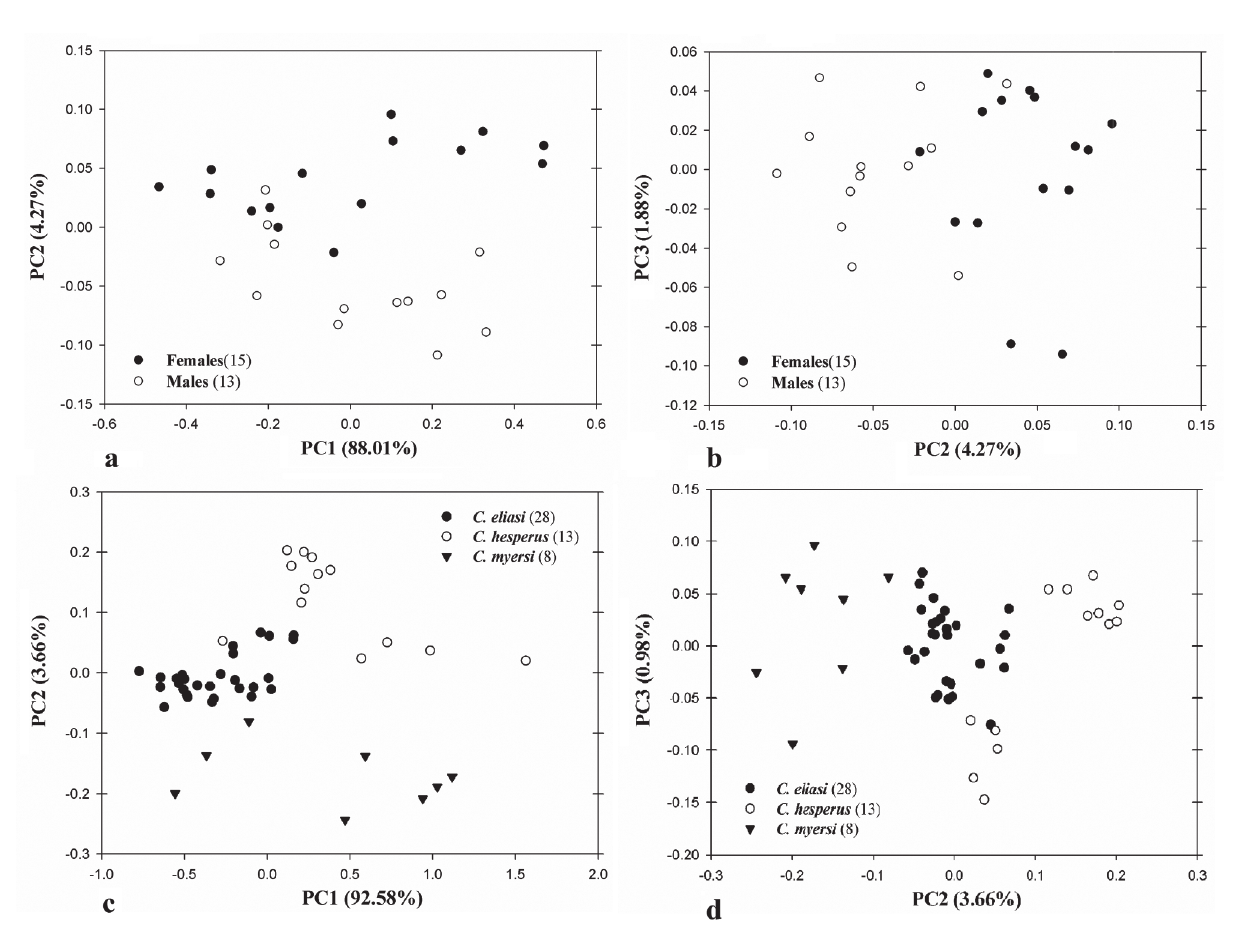
Fig. 6. Principal component analyses of morphometric data by sex of Chrysobrycon eliasi ( a-b ) and comparing Chrysobrycon species ( c-d ). PC1, PC2 and PC3 correspond to the first, second and third principal components,